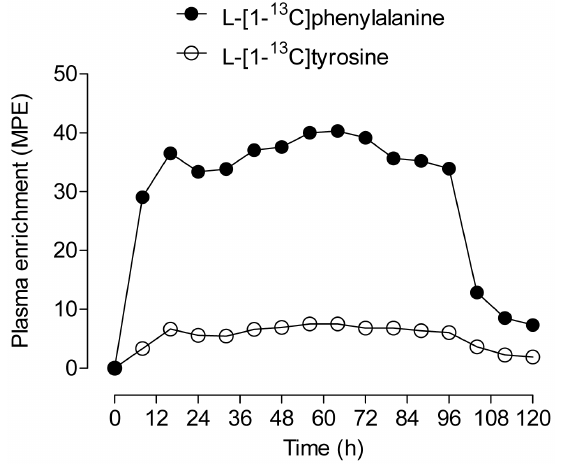
Figure 2. Cow plasma enrichments of L-[1- 13 C]phenylalanine and L-[1- 13 C]tyrosine before, during, and after the infusion protocol. Values are expressed as mole percent excess (MPE).